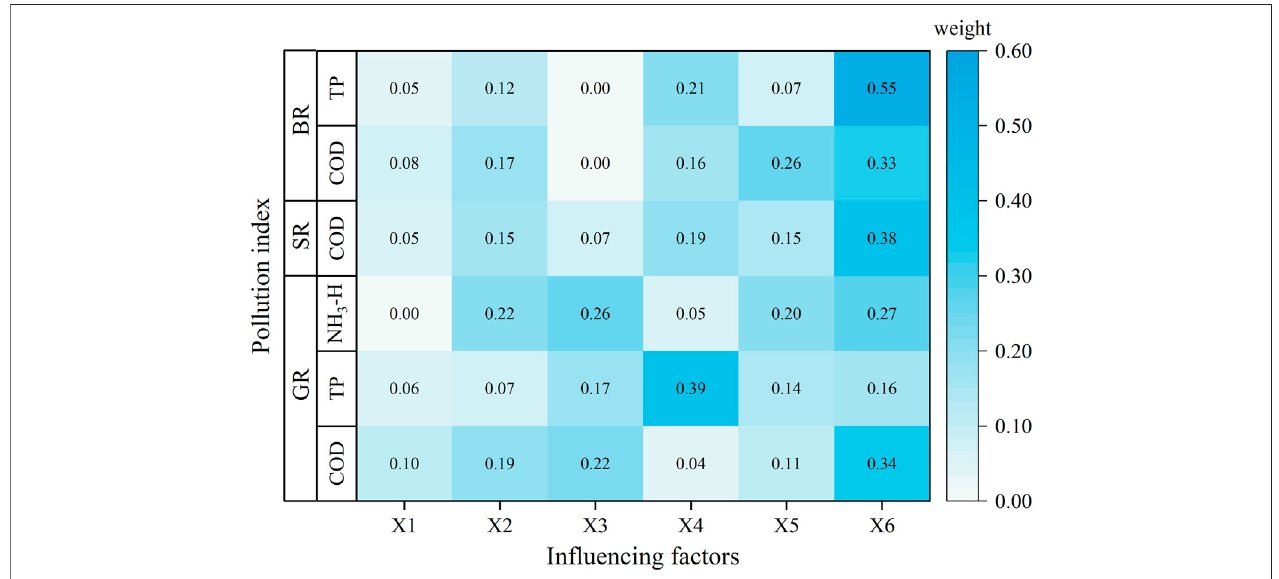
FIGURE 8 | Evaluation of the contribution weight of the six in fl uencing factors (X1: rainfall, X2: runoff, X3: water storage capacity, X4: sewage treatment capacity, X5: wastewater emissions and X6: GDP per capita).